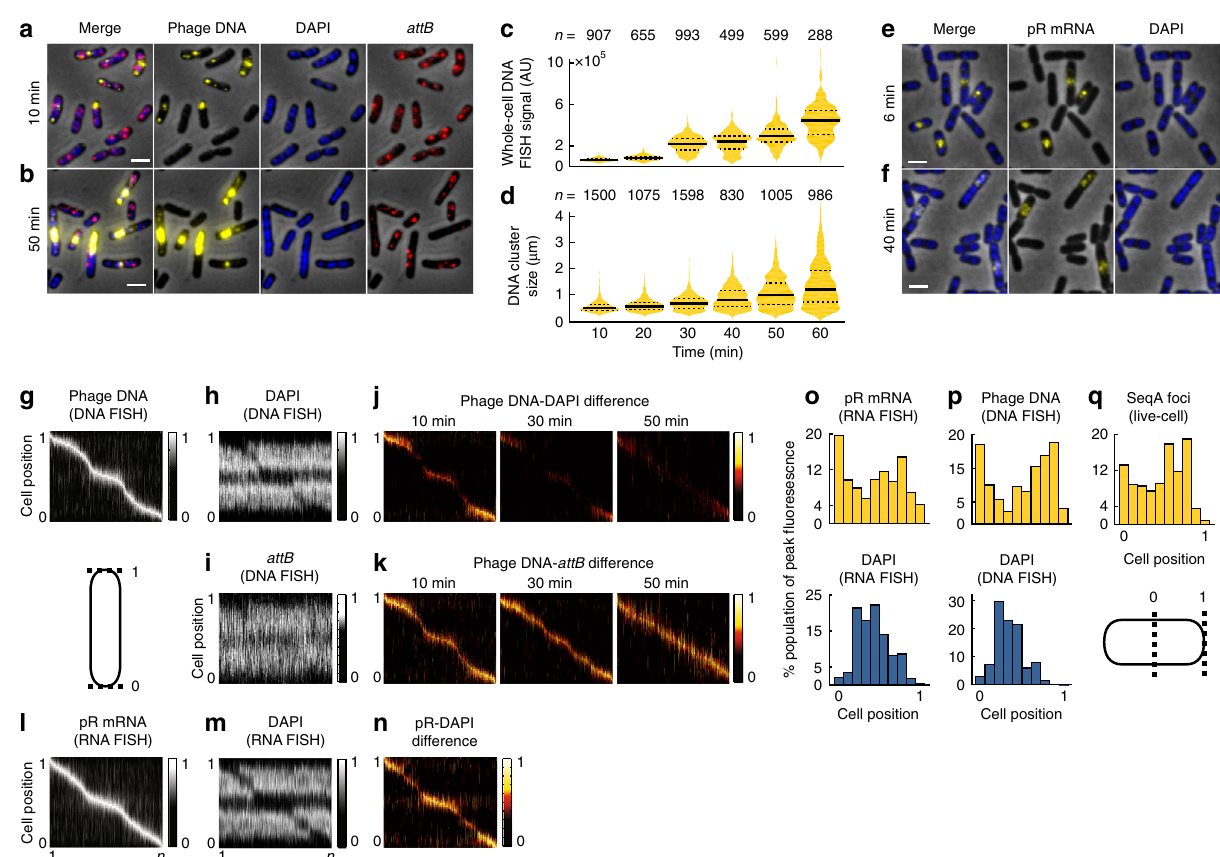
Fig. 4 Phage transcription and DNA replication are collectively organized within nucleoid-free regions. a , b DNA FISH labels phage and bacterial DNA. Representative images of DNA FISH experiments targeting phage DNA and attB at 10 min ( a ) and 50 min ( b ) post-infection with cells stained with DAPI. Representative cells chosen from six independent infection experiments. All scale bars in this fi gure are 2 μ m. c , d Violin plots of whole-cell phage DNA signal ( c ) and sizes of phage DNA clusters ( d ). In the violin plots, the solid line represents the median, and the dashed lines mark the bounds of the interquartile range of the data. e , f RNA FISH labels phage pR transcript at 6 min ( e ) and 40 min ( f ) post-infection. Cells stained with DAPI. Representative cells chosen from six independent infection experiments. g – i Phage DNA ( g ), DAPI ( h ), and E. coli attB ( i ) heat maps arranged by the location of peak brightness of phage DNA at 10 min post-infection. Cell below ( g ) shows how locations are represented for g – n . Fluorescence of each cell is normalized to its own peak brightness for g – i and l , m . n = 907 cells for g – i . j , k Phage DNA prefers nucleoid-free locations and avoids attB . j Difference maps (see Supplementary Discussion), calculated as g , h , show contrast in locations of phage DNA and DAPI. Negative values are set to 0. k Difference maps as in j , except showing differences between phage DNA and attB . n for j and k = n of c for each time point. l – n Phage mRNA prefers nucleoid-free locations. pR RNA FISH ( l ) and DAPI ( m ) heat maps arranged by the location of peak brightness of pR at 15 min post-infection. n Difference map of l , m , similar to j – k . p Histograms of peak location of phage DNA and DAPI from DNA FISH ( g , h ). q Histogram of peak location of SeqA signal from experiments in Fig. 1 (lytic cells, combined fi rst three time points). Cell below ( q ) shows how locations are represented for o – q . Source data are provided as a Source Data fi